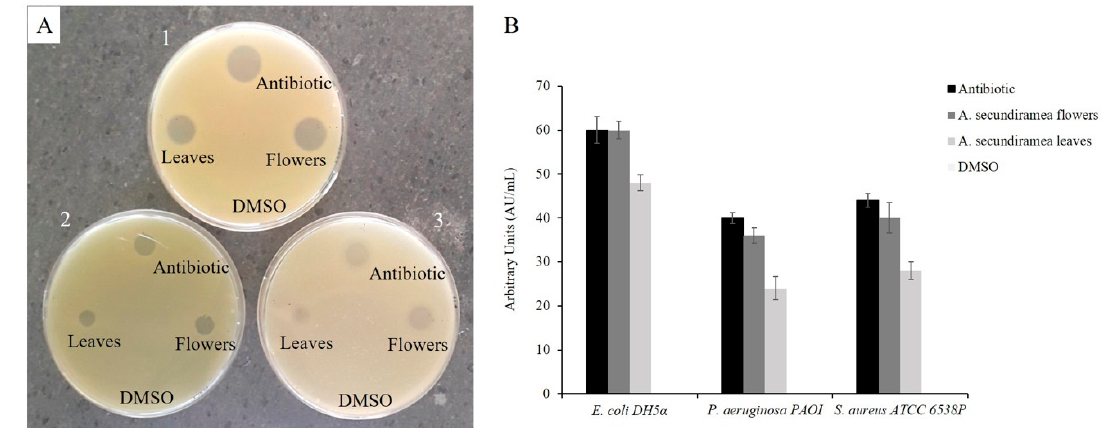
Figure 4. ( A ) Inhibition halo of A. secundiramea flowers and leaves essential oils against E. coli DH5 α (1), P. aeruginosa PAOI (2) and S. aureus ATCC 6538P (3). Positive and negative control is represented by antibiotics (2 Colistine, 1 and 3 Ampicillin), and dimethyl sulfoxide (DMSO 2%), respectively. ( B ) The inhibition halos, shown in panel A, are expressed in AU/mL Values are expressed as the average of three different experiments; standard deviations were always less than 10%.